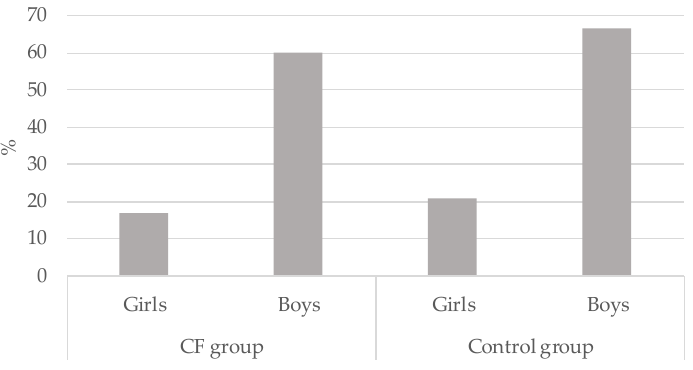
Figure 2. Percentage of physical activity guidelines accomplishment in cystic fibrosis (CF) children and control group by gender.